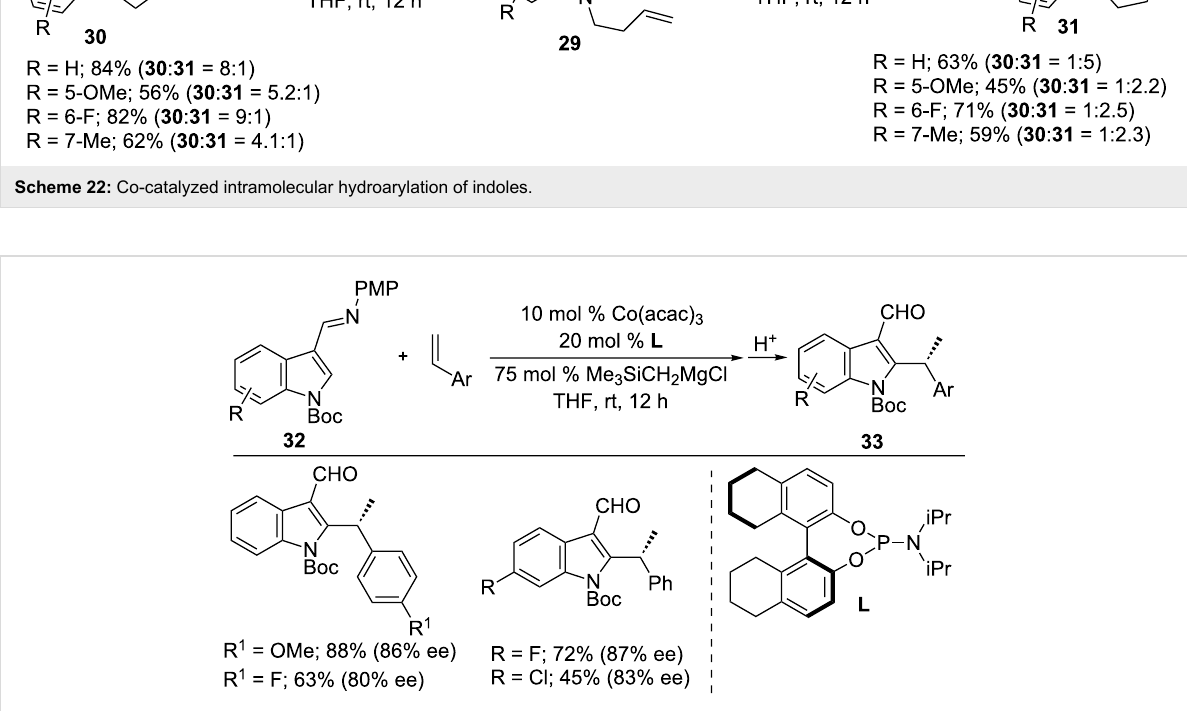
Scheme 23: Co-catalyzed asymmetric hydroarylation of alkenes with